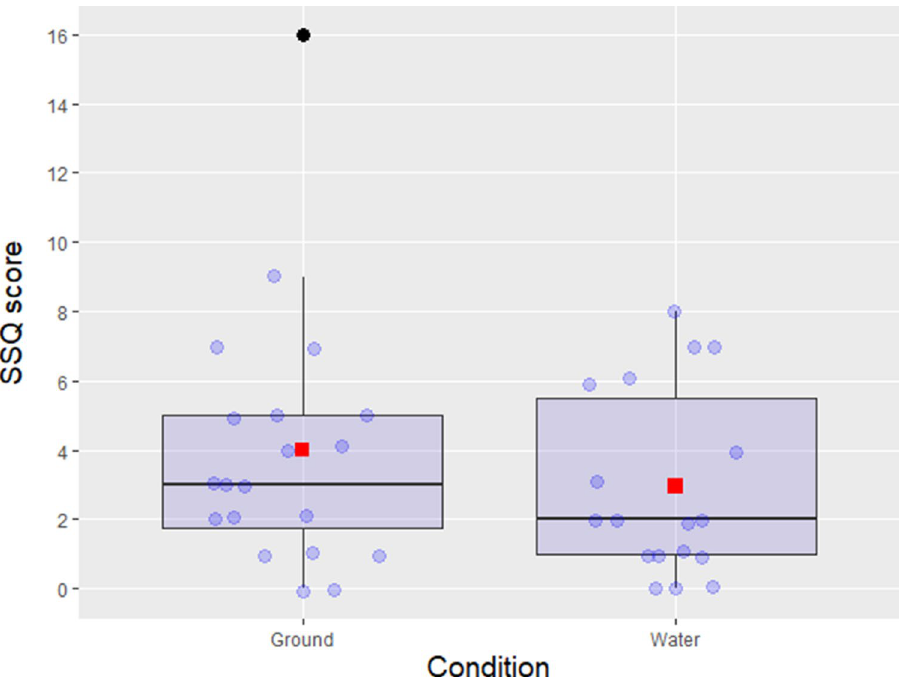
Figure 2. Comparison of the SSQ scores (sum of the 16 SSQ items) between Ground and Water conditions. Boxplot presenting medians, interquartile ranges, minimum and maximum and potential outliers. The boxplot also shows the means (red squares) for each condition and an outlier (black dot) in the Ground